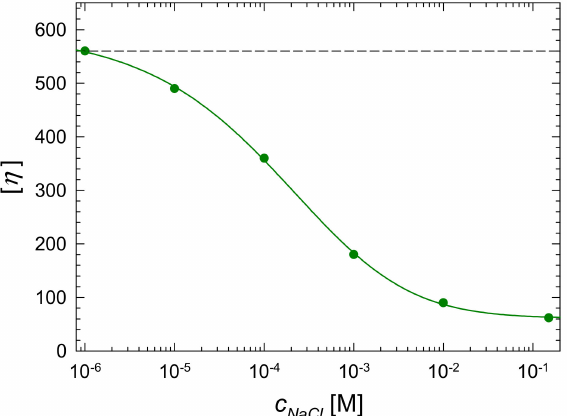
Figure 8. The dependence of the intrinsic viscosity [ η ] of P-Arg on the NaCl concentration. The points show the experimental data, the dashed lines show the theoretical slender body limit for fully extended molecules predicted from MD modeling and the solid lines denote the nonlinear fit of experimental